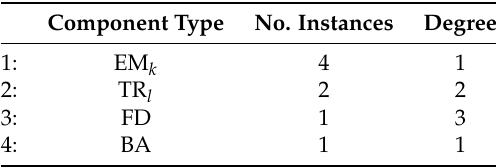
Table 1. Powertrain system